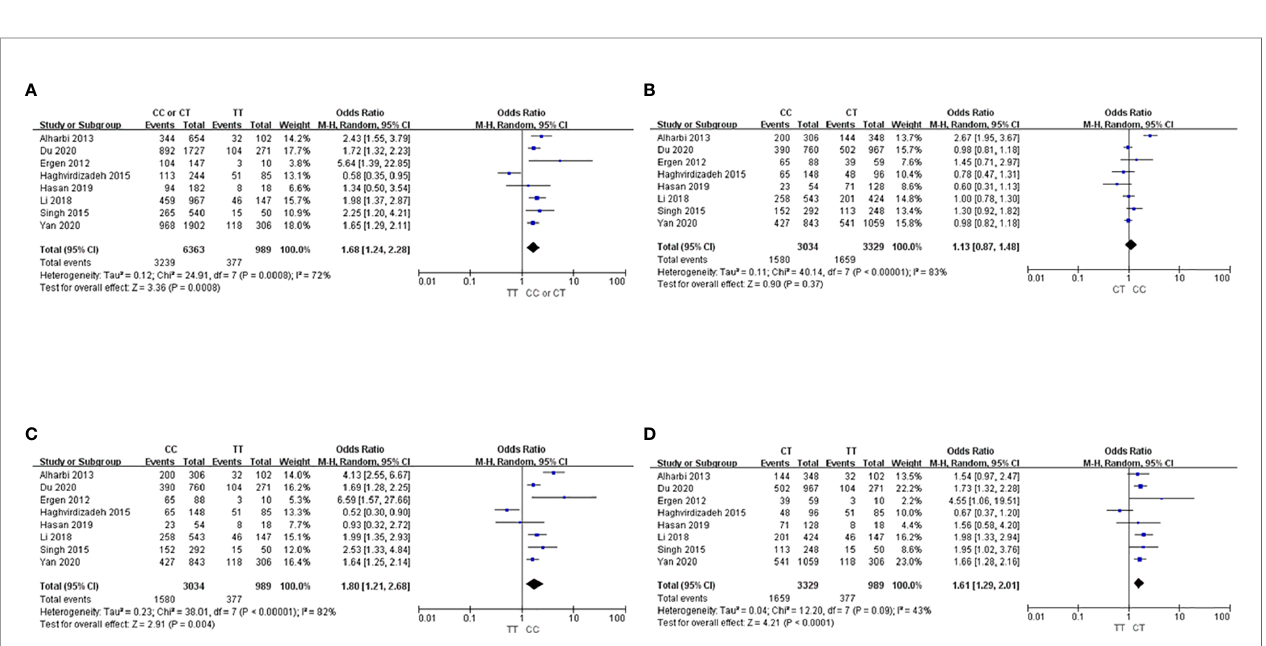
FIGURE 3 | Forest plots showing the association between the ABCA1 69C>T genotype and T2DM risk in Asians. (A) CC or CT vs. TT, (B) CC vs. CT, (C) CC vs. TT, (D) CT vs. TT.